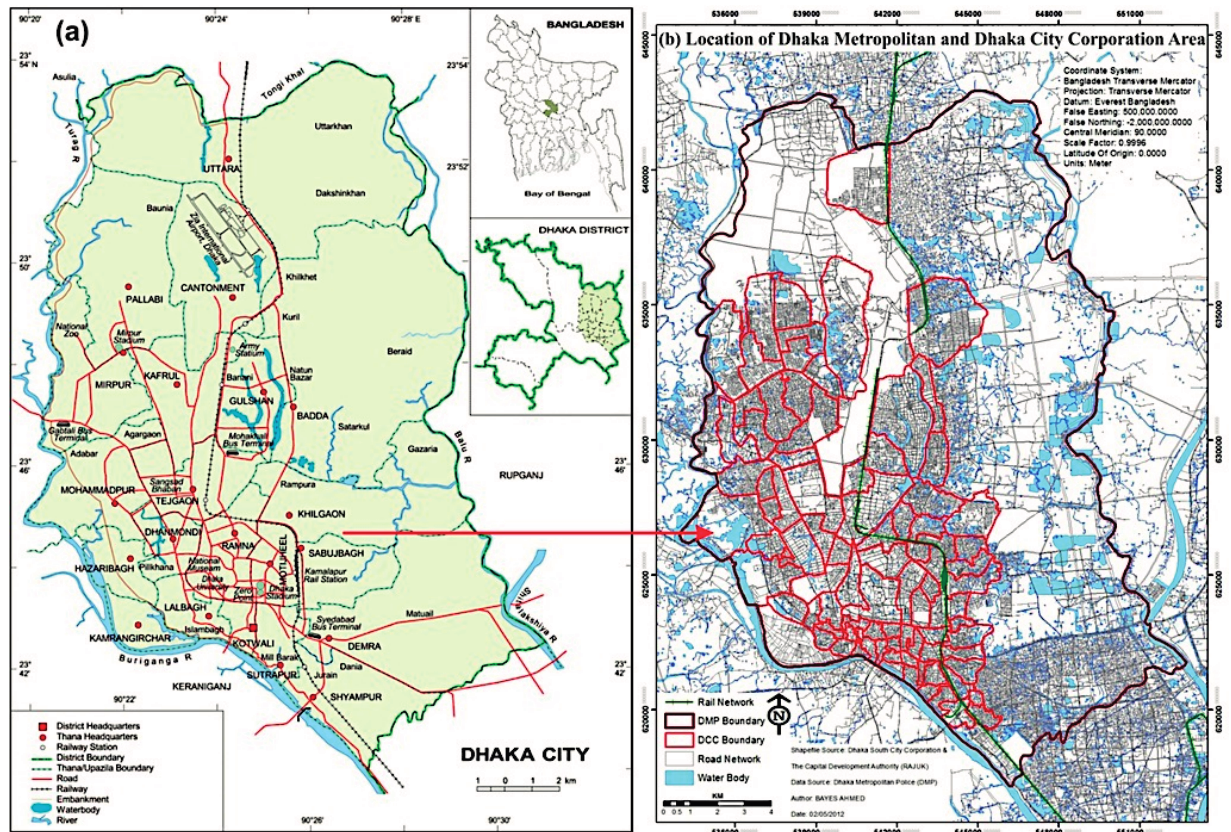
Figure 1. Location of Dhaka Metropolitan Area ( a ) in Bangladesh and ( b ) in Dhaka City Corporation (DCC). Source: (a) Banglapedia , National Encyclopedia of Bangladesh, 2014, and (b) the Capital Development Authority ( RAJUK ), Dhaka, Bangladesh,